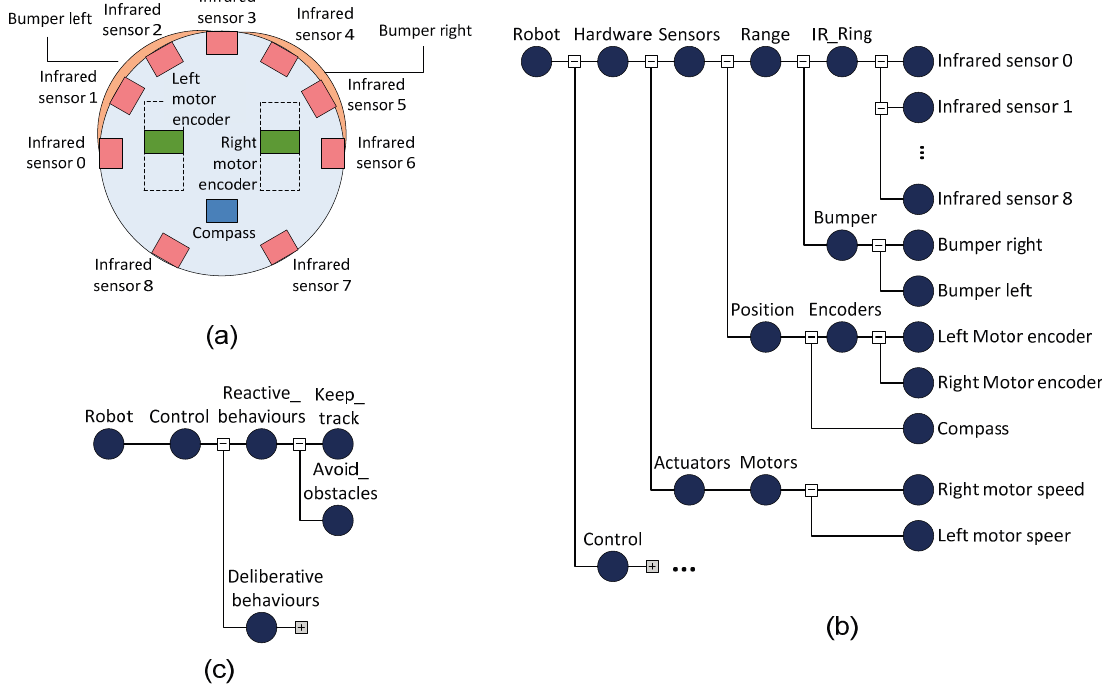
Figure 5. ( a ) Sensors of a robot whose information will be transmitted using a LNT; ( b ) LNT of the mobile robot represented on (a); ( c ) LNT used to organize the control behaviours.